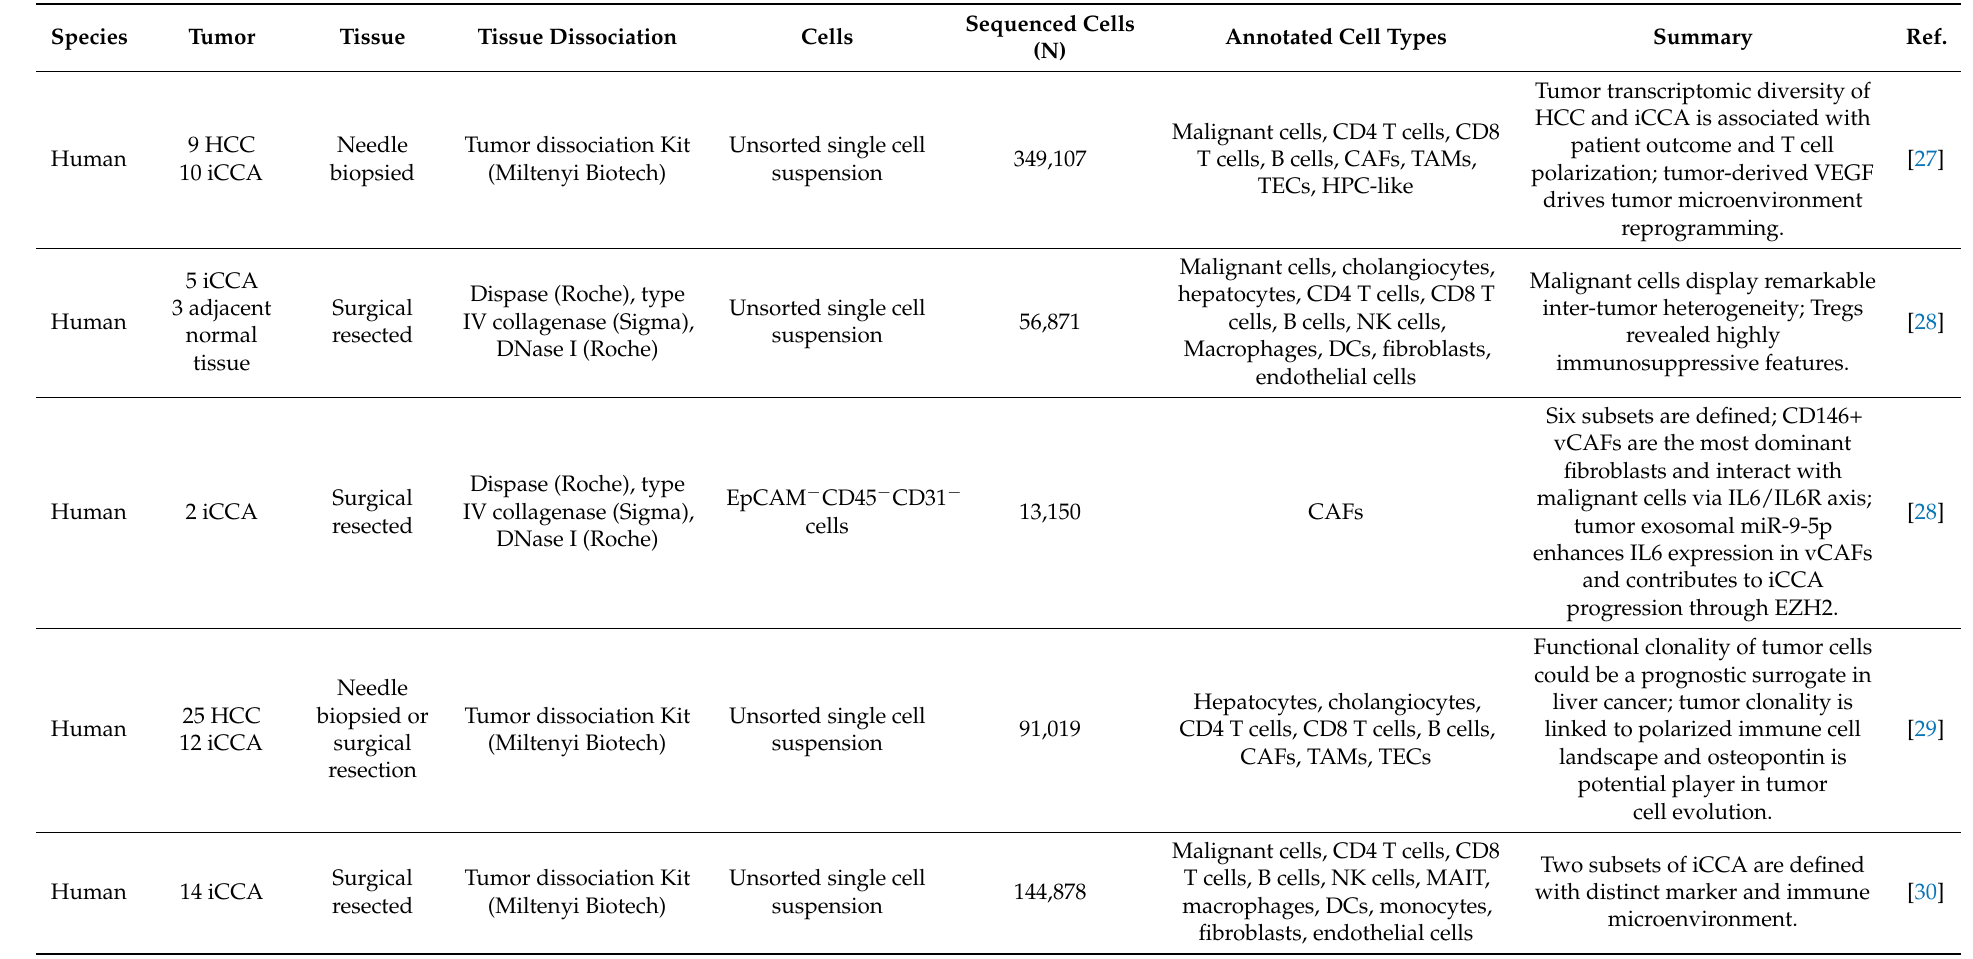
Table 1. Overview of single cell RNA sequencing studies in